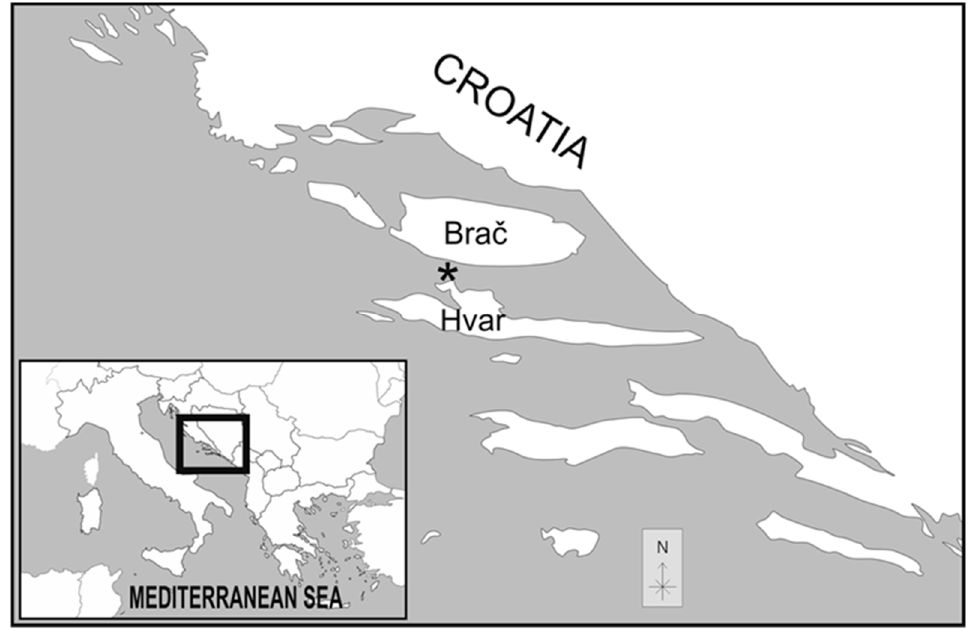
Figure 1. Location of the study area (*).